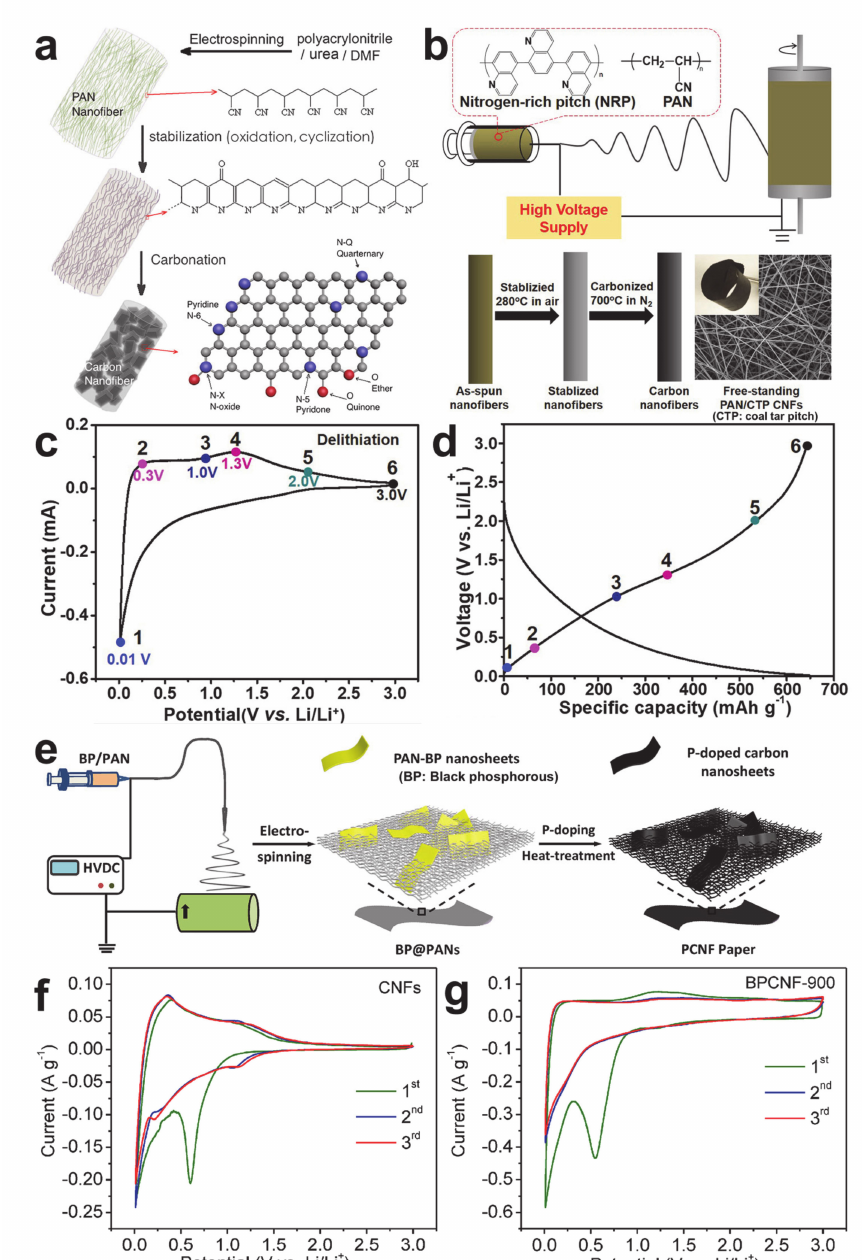
Figure 3. Heteroatom-doped carbon nanofiber anode materials. Schematic diagrams of nitrogen-doped carbon nanofibers fabrication processes based on ( a ) urea (reprinted with permission from [42]; copyright 2016 American Chemical Society), ( b ) nitrogen-rich pitch (reprinted with permission from [43]; copyright 2018 Elsevier), and the electrochemical performances of the nitrogen-doped carbon nanofibers: ( c ) cyclic voltammogram and ( d ) voltage profile (reprinted with permission from [43]; copyright 2018 Elsevier). ( e ) Schematic diagram of the phosphorous-doped carbon nanofiber fabrication process, and cyclic voltammograms of ( f ) pristine and ( g ) phosphorous-doped carbon nanofibers. Reprinted with permission from [44]. Copyright 2018 Elsevier. CNF, carbon-based